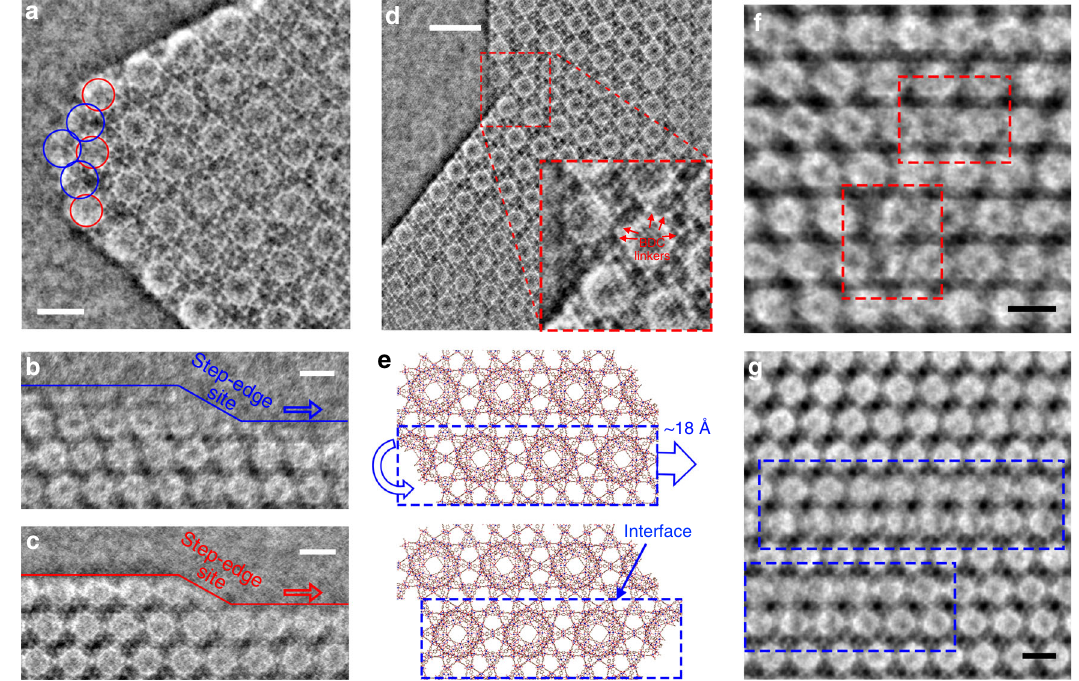
Fig. 4 Revealing the local structures in the MIL-101 crystals. a The iDPC-STEM image showing the terminations of a corner in the octahedral MIL-101 crystal. The 34 Å cages (marked by the blue circles) were exposed at this corner. Scale bar, 5 nm. b , c The iDPC-STEM images showing the surface steps and step-edge sites of the MIL-101 crystals with two types of surface terminations, respectively. Scale bars, 5 nm. d The iDPC-STEM image showing the interface structures at a twin-plane boundary. Scale bar, 10 nm. e The structural model of the twin-plane interface imaged in d . The interface was formed by horizontally fl ipping and moving the marked part (below) to match the part above again. f , g The iDPC-STEM images showing the line ( f ) and plane ( g ) defects on the twin-plane interface. These defects lasted through the whole atom arrays parallel to the electron beam. Scale bars, 5